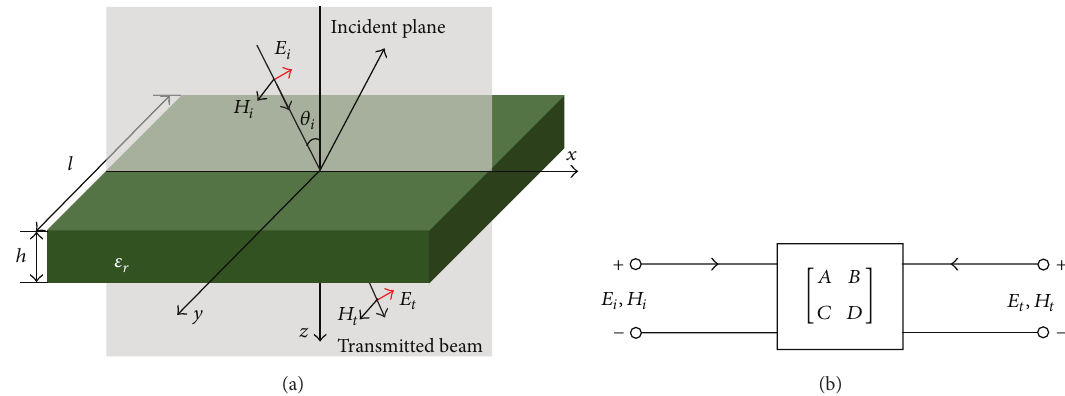
Figure 1: (a) 3D topology of a subwavelength dielectric building block for oblique incident TM waves and (b) the equivalent two-port transmission line circuit